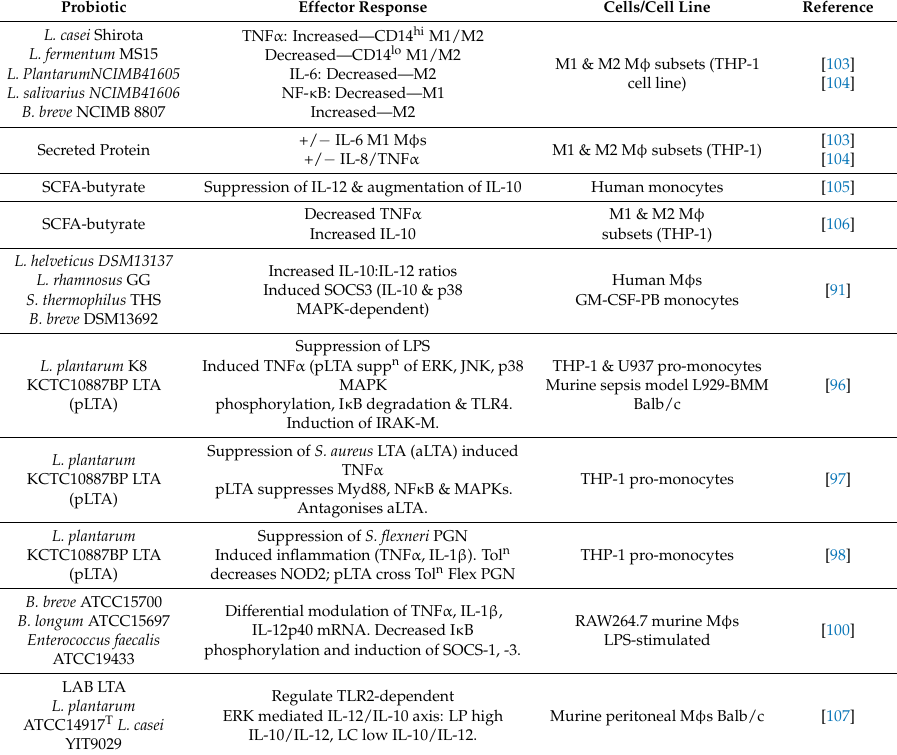
Table 4. Probiotic modulation of signaling pathways in macrophage